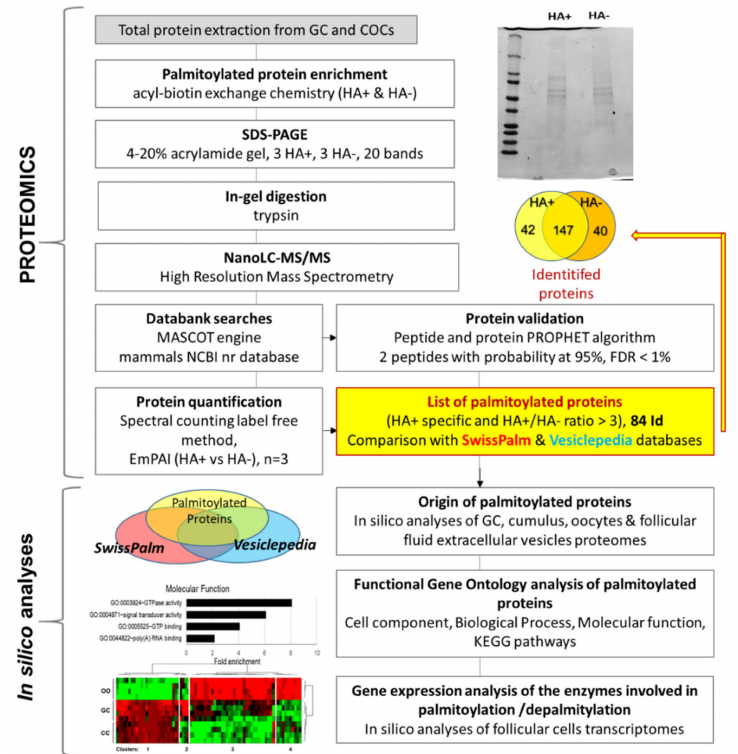
Figure A1. General workflow of protein palmitoylation analyses in bovine follicular